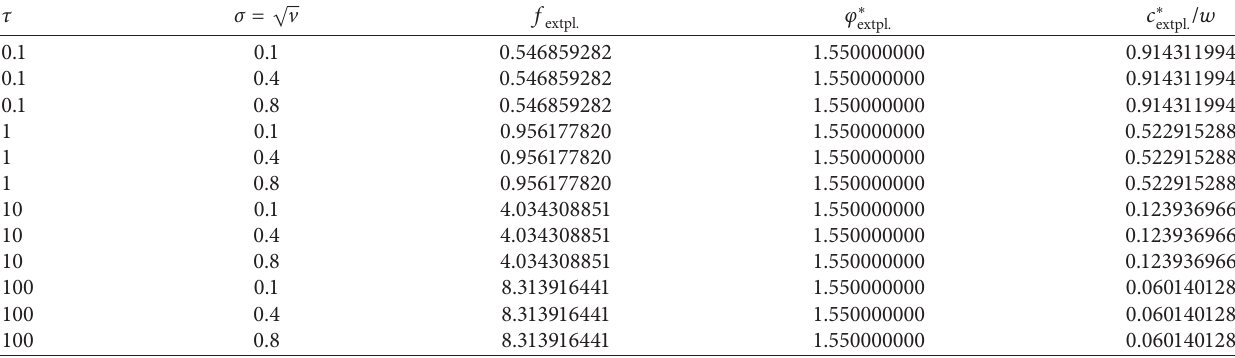
Table 14: Numerical solutions for f, φ ∗ , and c ∗ / w after performing Richardson’s extrapolation. Here, α � 0 . 5, c � 1, and Δ τ � Δ v � 0 . 001. Other parameter values are the same as those in Table 1.